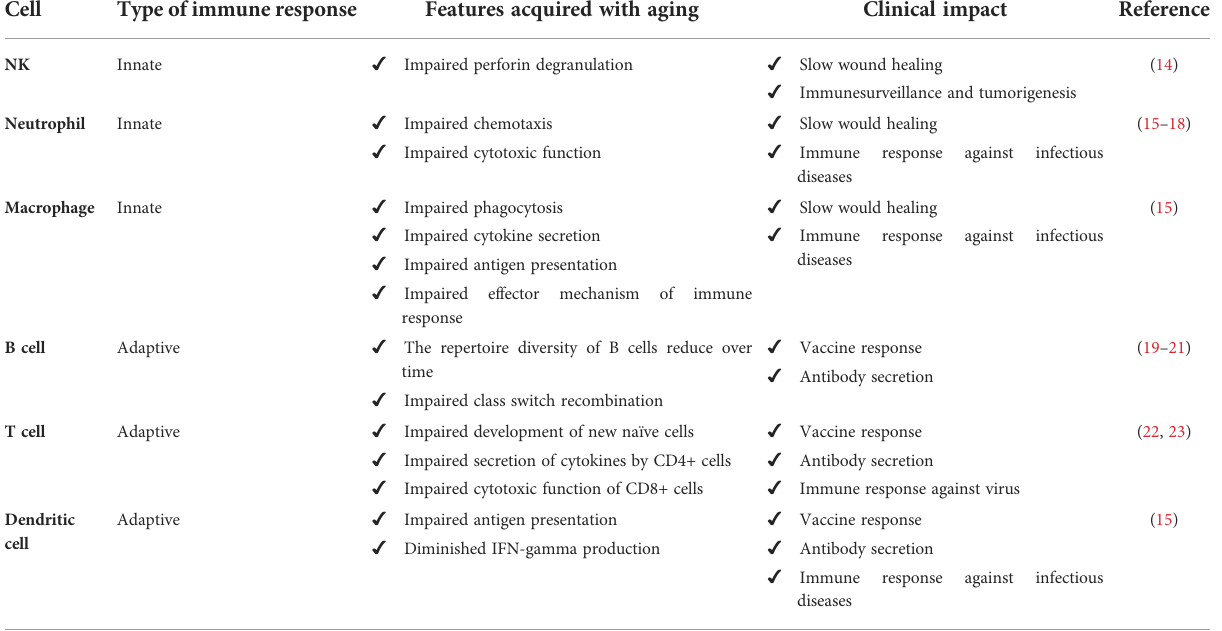
TABLE 1 Physiologic alterations that immune cells face with